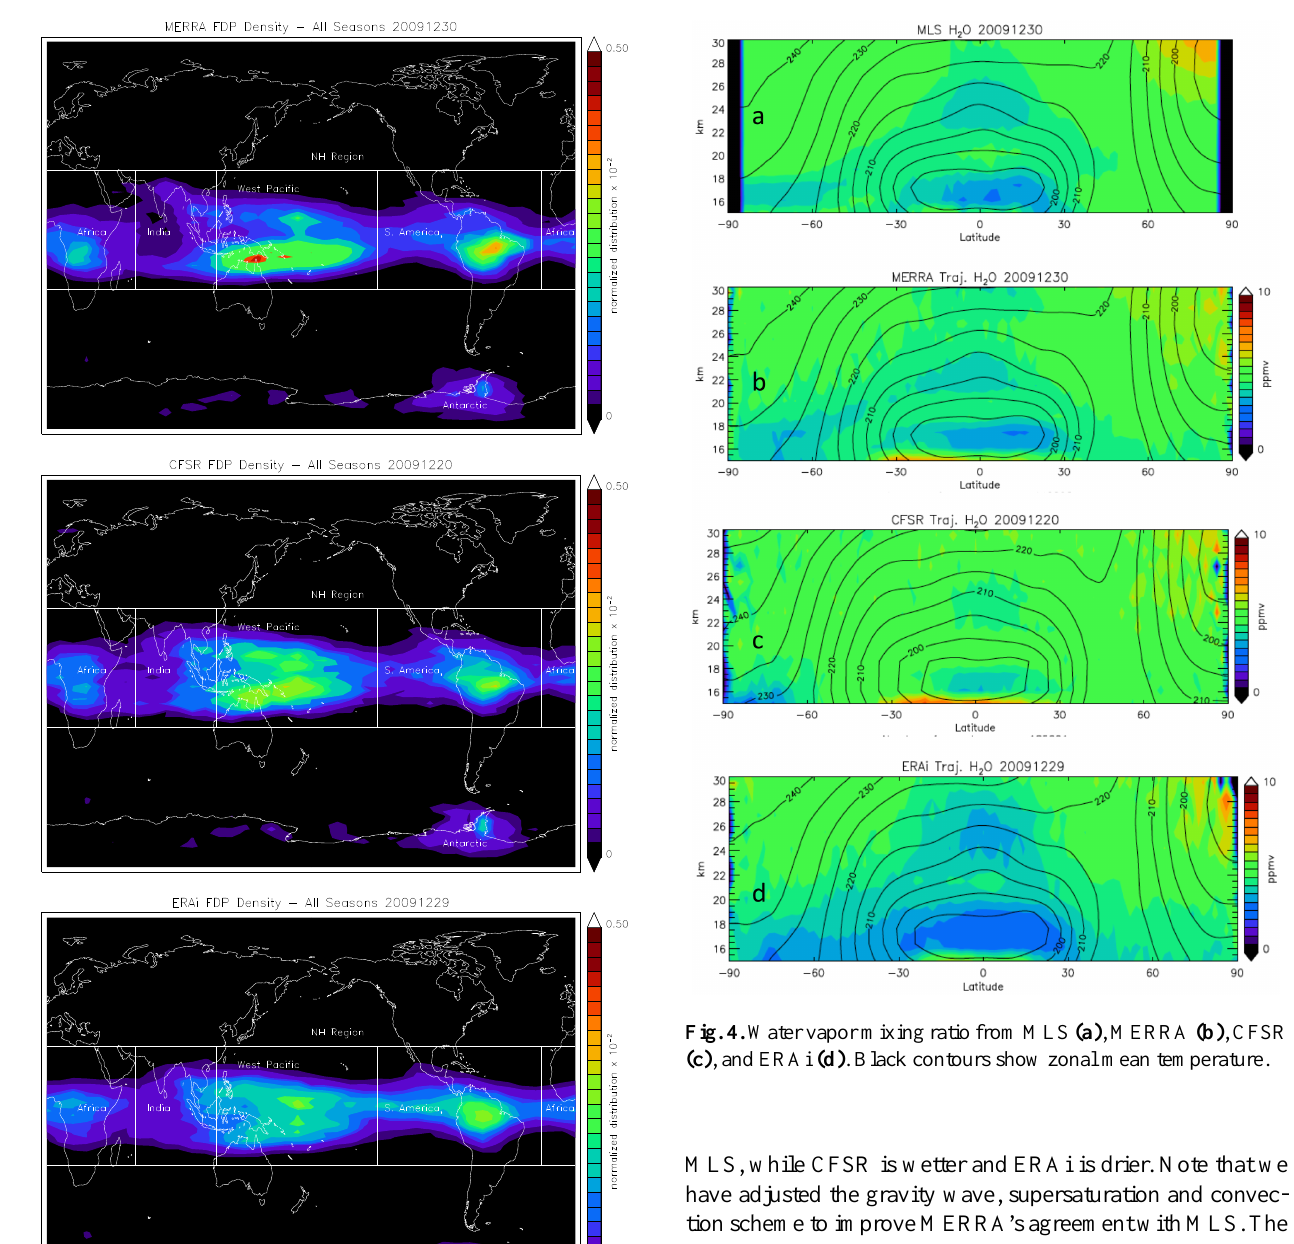
Figure 3. Density of final dehydration locations from the three reanalyses, (a) MERRA, (b) CFSR, and (c) ERAi.